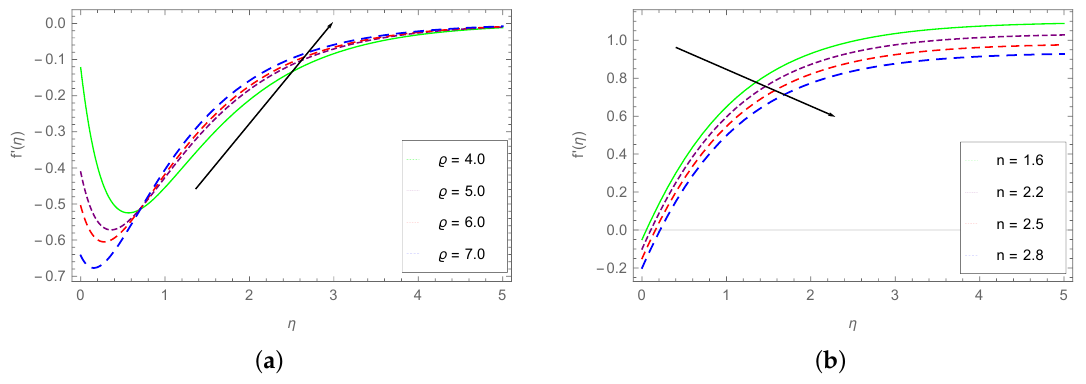
(cid:48) ( η ) with shrinking parameter ( (cid:36) ) and the index of power law ( n ) The variation of f is depicted respectively in the Figure 5a,b. The values of (cid:36) used are 4.0, 5.0, 6.0, 7.0, while (cid:48) ( η ) first drops, those of n are 1.6, 2.2, 2.5, 2.8. It is observed from Figure 5a that at fixed (cid:36) , f (cid:48) ( η ) profiles first reaches to minimum and then enhances with increasing η . Similarly, the f drop and then augment with enhancing (cid:36) . Thus, due to suction ( (cid:36) > 0) during the Carreau (cid:48) ( η ) profiles rise beyond η = 1. Beyond η = 3.8, all the curves for different fluid flow, the f (cid:48) ( (cid:36) overlap with one another. Figure 5b shows the variation of f η ) with changing values of (cid:48) ( η ) augments with higher η the power law index n . The Figure shows that, at fixed n , f (cid:48) ( η ) is larger for lower η values in comparison with values. The rate of enhancement in f (cid:48) ( (cid:48) ( η ) profiles drop. The spacing between f η ) larger η . By enhancing the values of n , the f curves at different n increases with rising η as clear from the Figure.